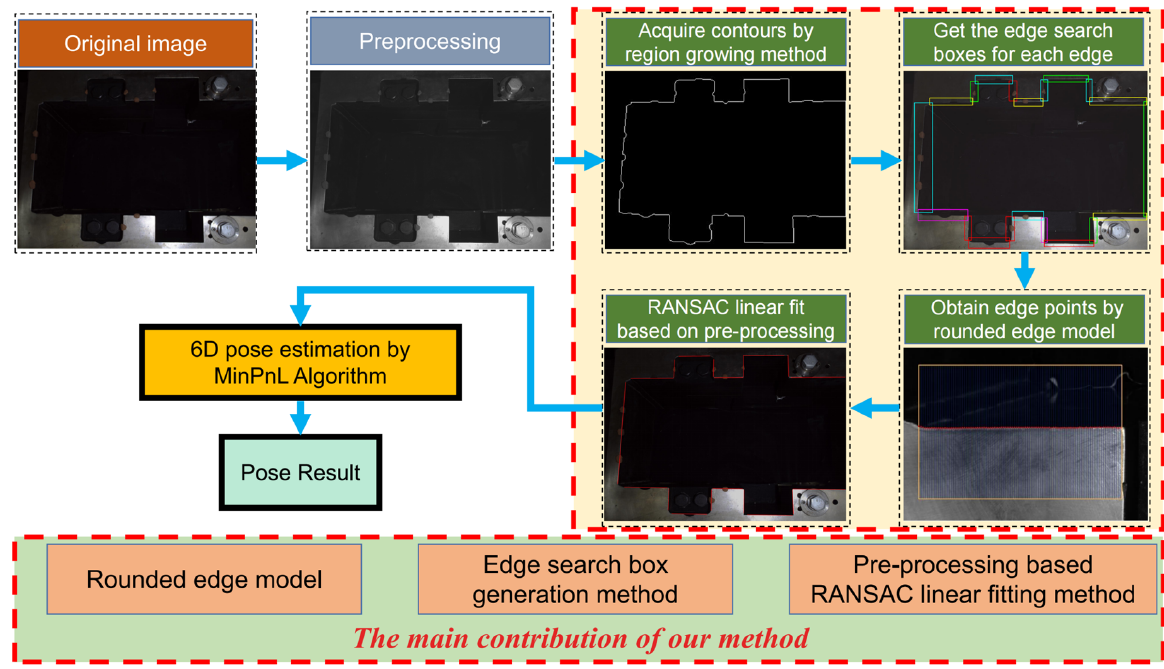
Figure 3. The flowchart of our proposed method.